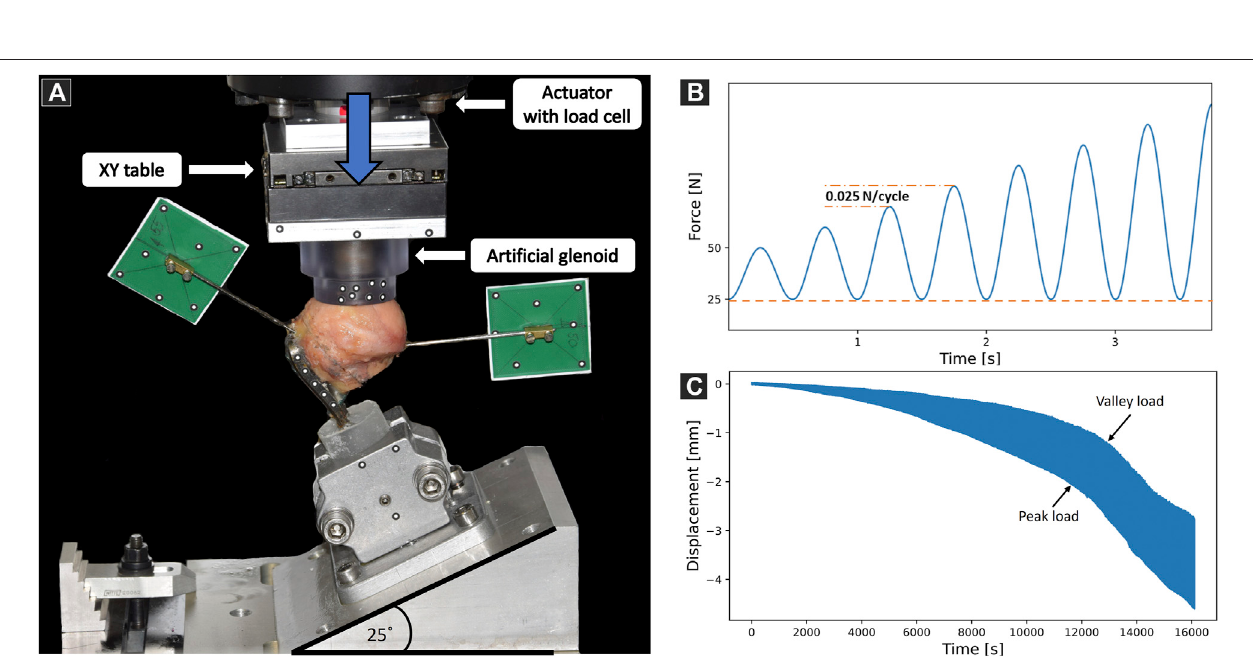
FIGURE 5 | (A) Biomechanical test setup with a specimen mounted on a metal wedge, inclined at 25 ° with respect to the machine base. Vertical arrow indicates loadingdirection.Motiontrackingmarkerswereattachedtotrackthearti fi cialglenoid,theplate,themountingjigandthetwobonefragments. (B) Biomechanicalloading protocol consisting of sinusoidal curves with constant valley load (dashed line) and gradually increasing peak load (dashed-dotted line). (C) Exemplary results showing the evolution of humeral head center displacement along the anatomical shaft axis over time.